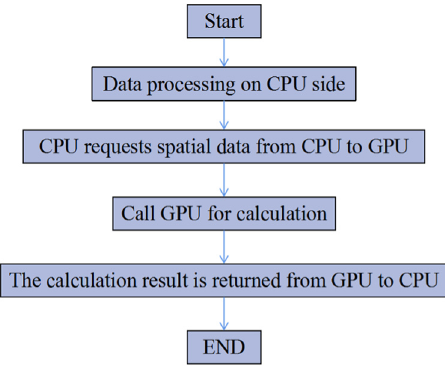
Figure 1: Heterogeneous platform